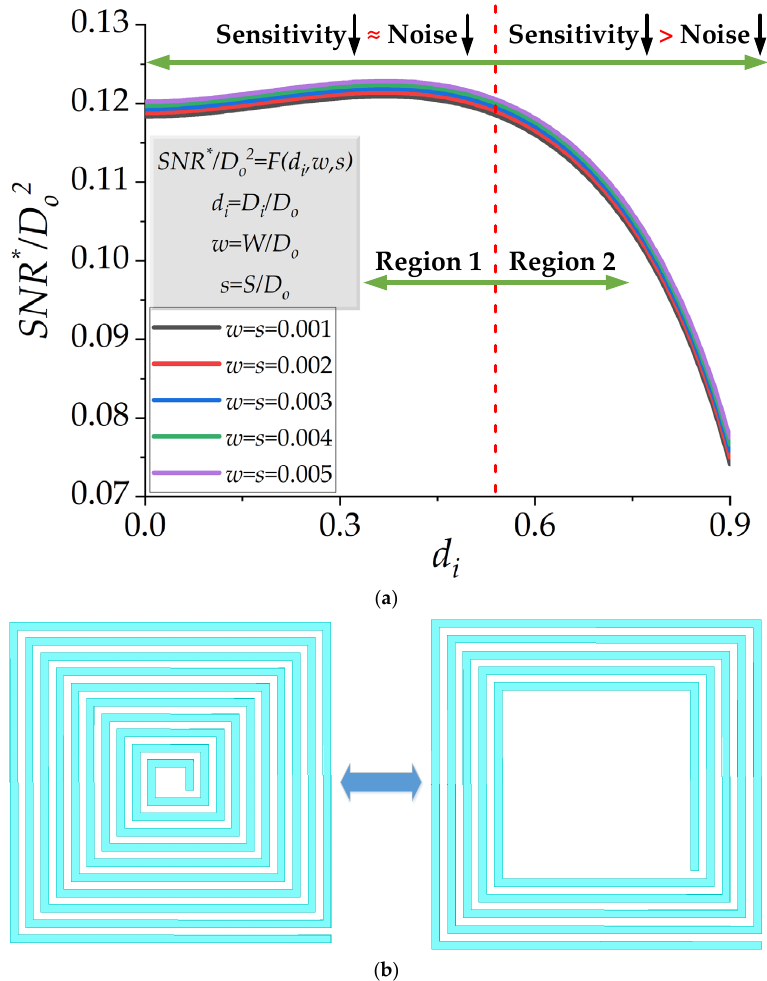
Figure 2. ( a ) SNR*/D o2 as a function of normalized D i ( d i ) shows the existence of the critical size of the normalized inner diameter d i (~0.5). ( b ) Dimensional analysis proves that the same SNR * / D o2 can be achieved with a reduced number of turns, which can improve the quality factor and bandwidth of the µ